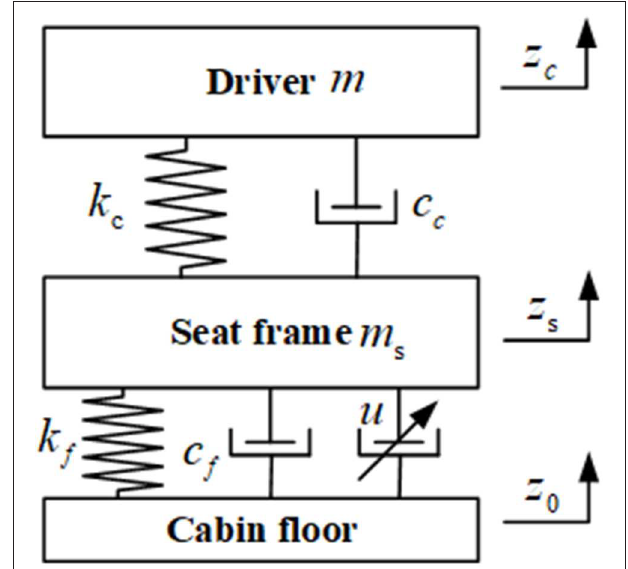
FIGURE 11 | Two degree of freedom suspension model.